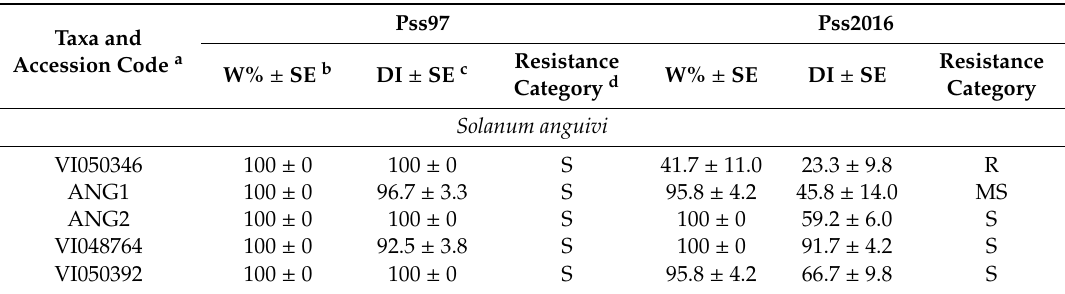
Table 2. Evaluation of resistance of 47 cultivated and wild relatives of eggplant accessions against Ralstonia solanacearum strains Pss97 and Pss2016 at four weeks after inoculation. Taxa